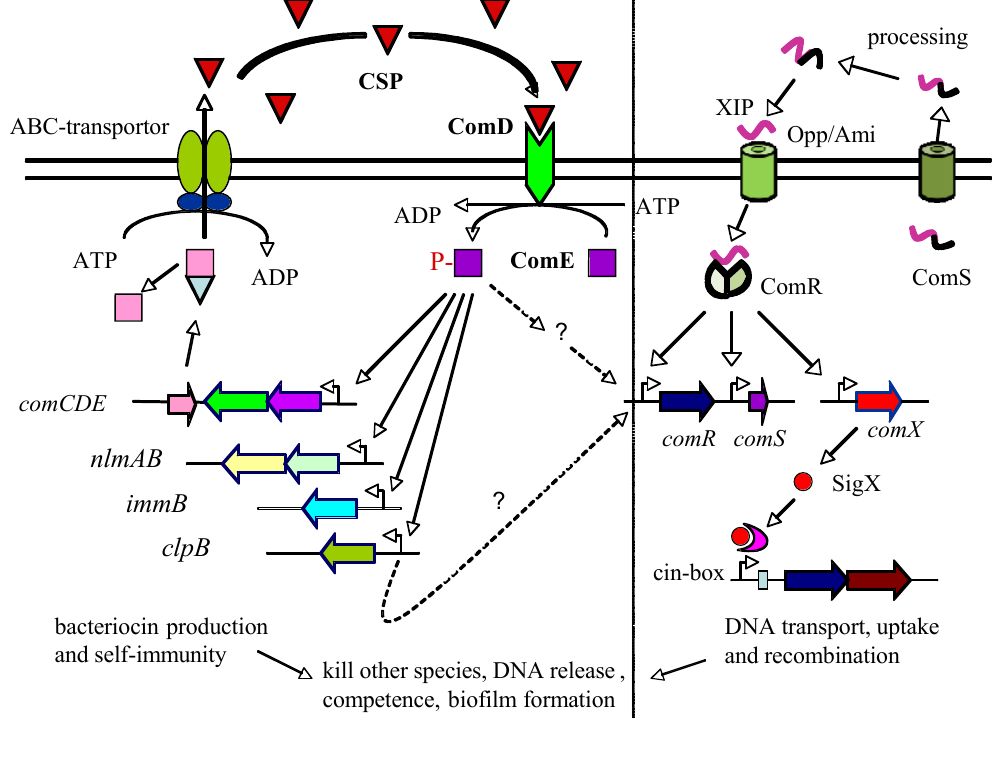
Figure 2. A schematic diagram indicating two types of signaling peptide-mediated quorum-sensing systems in Gram-positive bacterium, S. mutans . The